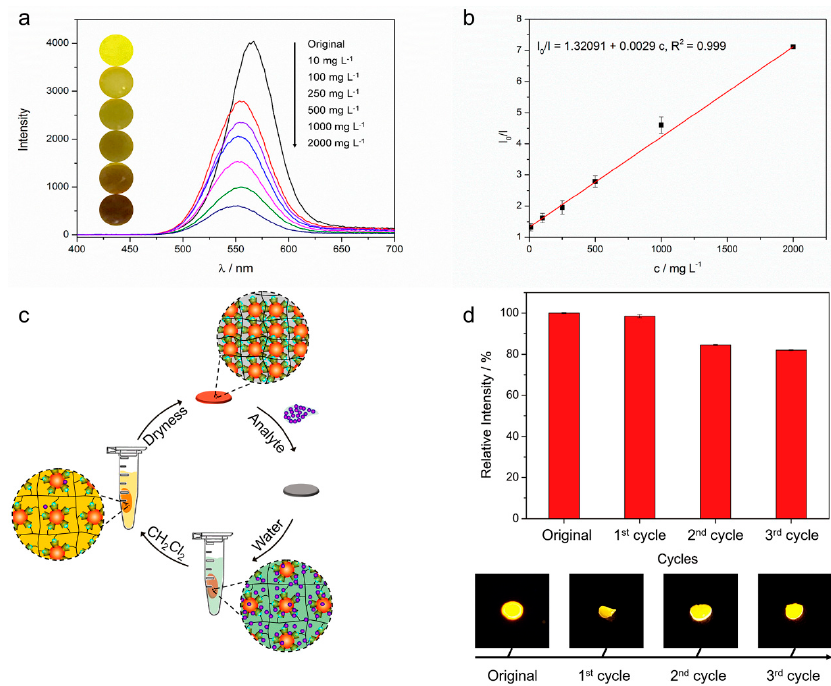
Figure 4. The detecting performance and reusable property of the xerogel. ( a ) Fluorescence spectra of the xerogel with different concentration Van ( λ ex = 380 nm). At the left is the corresponding photographs under ultraviolet light ( λ ex = 365 nm); ( b ) Calibration plot between I 0 / I and the concentration of Van (c, mg/L); ( c ) Schematic illustration of the reclamation process; ( d ) The relative fluorescence intensity between the original xerogel and the recycled ones. The fluorescence intensity of the original xerogel is set as 100%. Below this are photographs of the corresponding xerogels under ultraviolet light ( λ ex = 365 nm). For the above test samples, Van is dissolved in PBS (pH = 8.01, 50 mM).